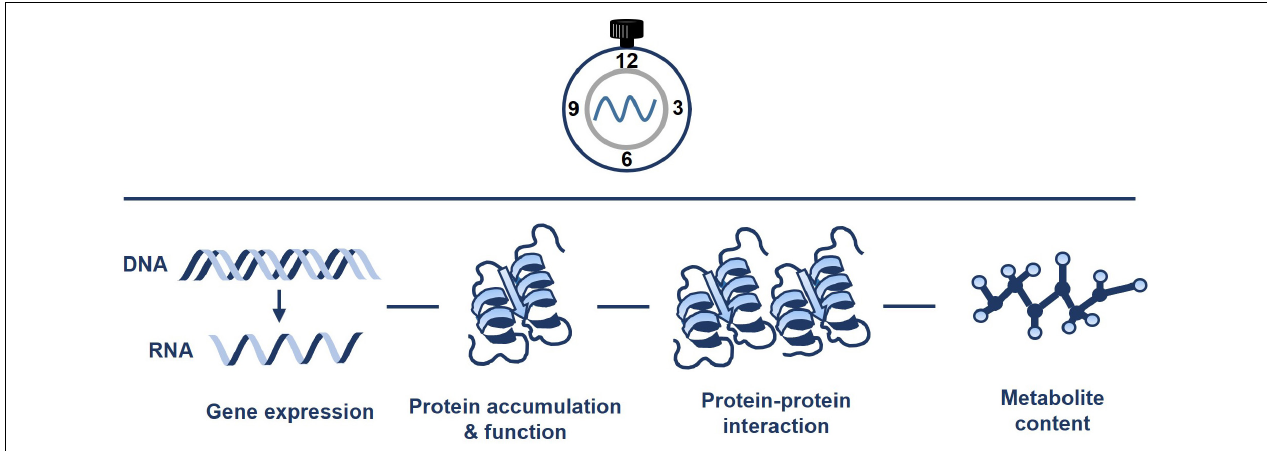
FIGURE 2 | Pervasive diel and circadian oscillation of mitochondrial activity. The circadian clock regulates the timing of mitochondrial activity. Connections of the clock with mitochondria include the regulation of gene expression, protein accumulation and function, protein-protein interaction and metabolite content. Please refer to the text for further